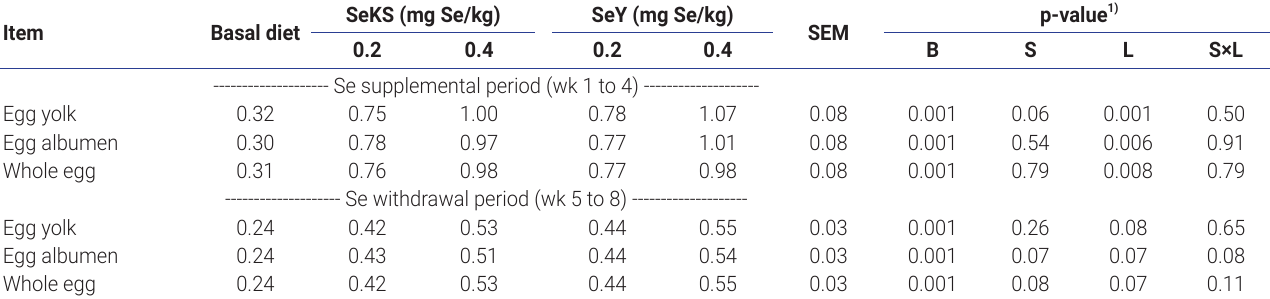
Table 5. Selenium concentrations (mg/kg DM) in egg yolk, egg albumen and whole egg of laying hens in the selenium supplemental and with- drawal periods